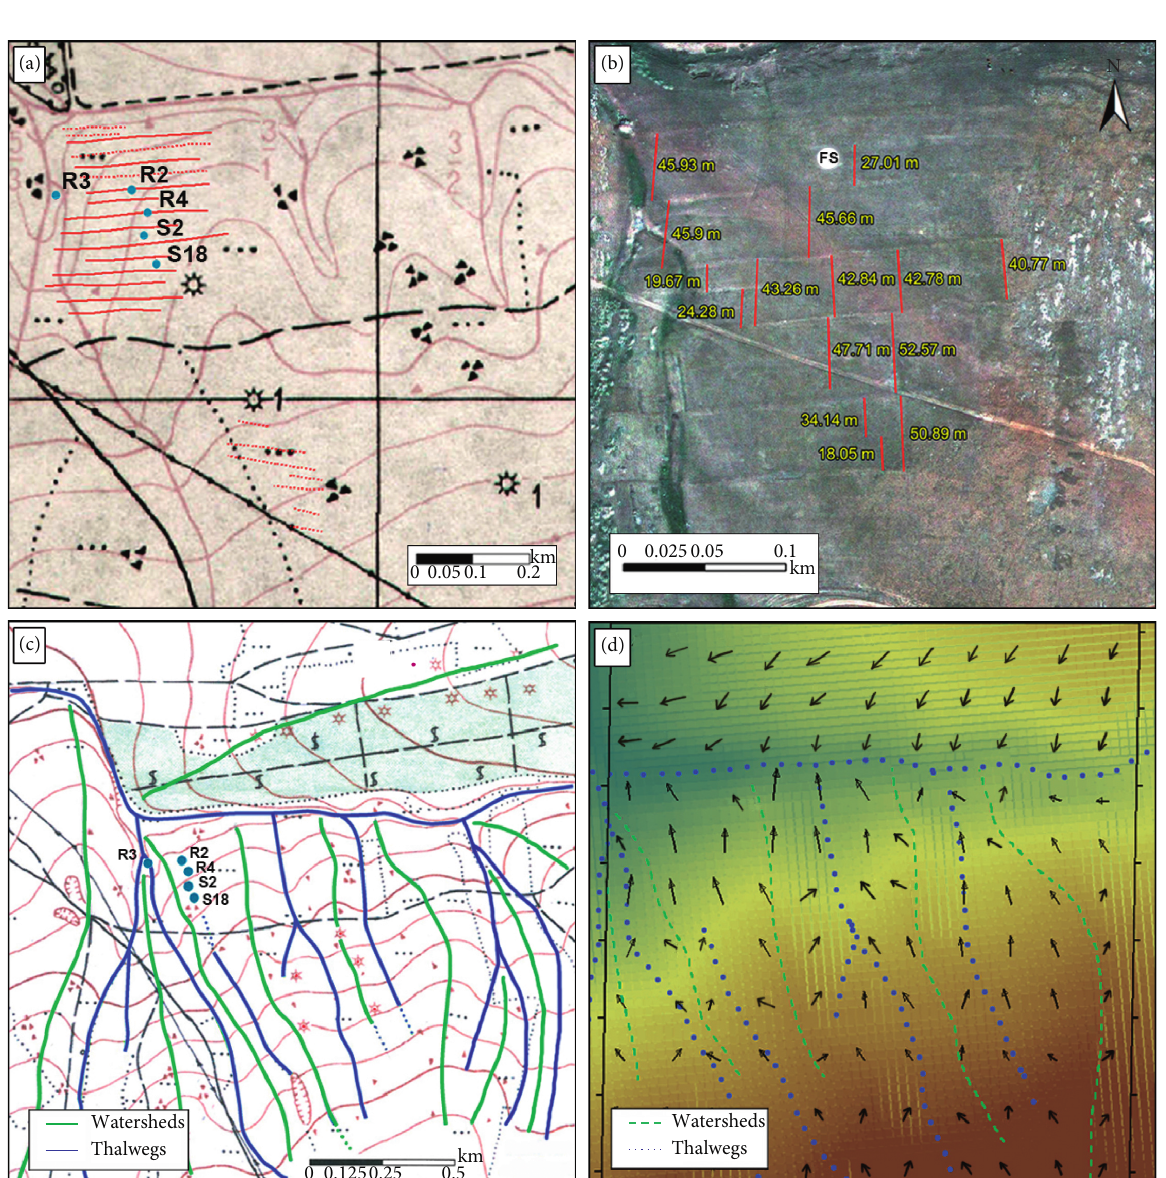
Figure 1: Postagrogenic landscape in the area of settlement S11–029 (last quarter of the 4 th to first third of the 3 rd c. BC). (a) Division walls detected on satellite images superimposed on a topographic map (red lines: earthen walls; blue dots: soil sections). (b) Satellite image of the same area (FS: ancient farmhouse). (c) Water catchment area of the site. (d) Digital elevation model of the site area with water flow